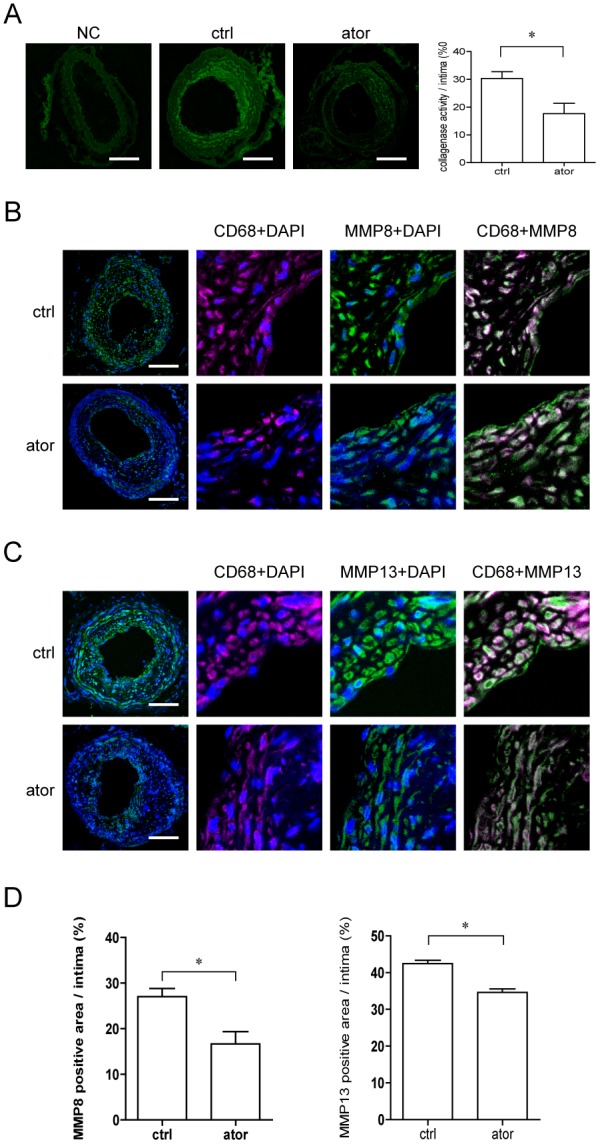
Effect of atorvastatin (10 mg/kg/d ) on collagenase activity and MMP-8 and MMP-13 expression in the neointima.(A) Representative images of in situ collagenase activity (scale bar  = 100 µm) and quantification in the control and atorvastatin-treated groups (*p<0.05, n = 6). (B) Representative images of MMP-8 immunohistochemical labeling (scale bar  = 100 µm) and quantification in the control and atorvastatin-treated groups (*p<0.05, n = 6). (C) Representative images of MMP-13 immunohistochemical staining (scale bar  = 100 µm) and quantification in the control and atorvastatin-treated groups (*p<0.05, n = 6). Values are the mean ± SEM.